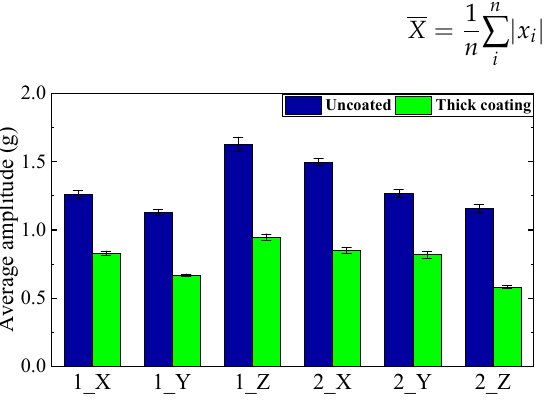
Figure 8. Average amplitude and standard deviation of vibration acceleration.